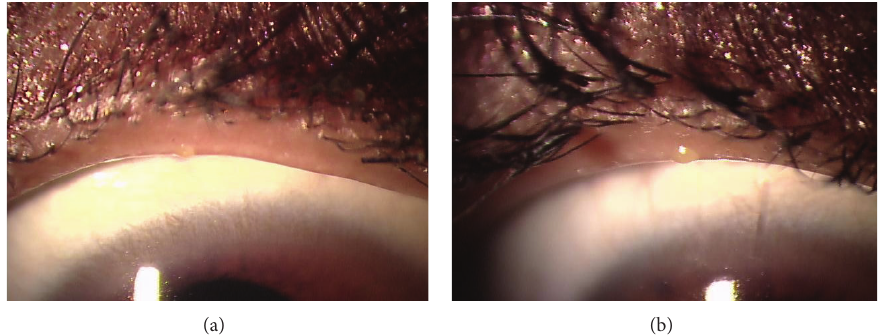
Figure 8: Tapioca sign in the upper eyelid, with no improvement after 4 weeks; eyelash extensions are present in both images. (a) Week 0. (b) Week 4, after using artificial